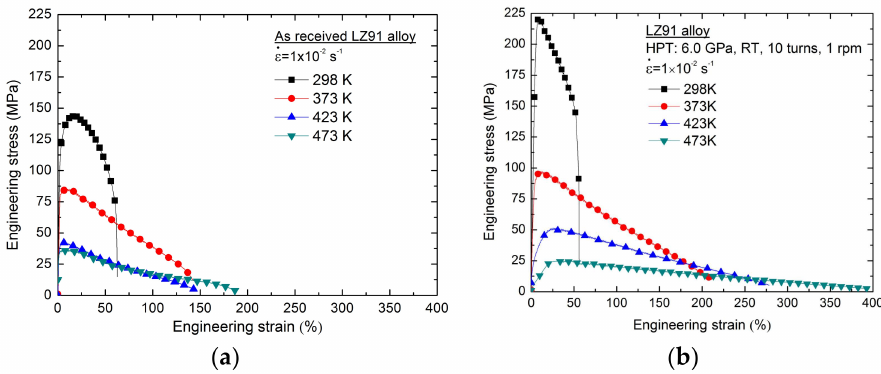
Figure 9. Engineering stress-engineering strain curves of LZ91 alloy ( a ) Before and ( b ) After HPT processing through 10 turns at different temperatures with a strain rate of 1 × 10 − 2 s − 1 .